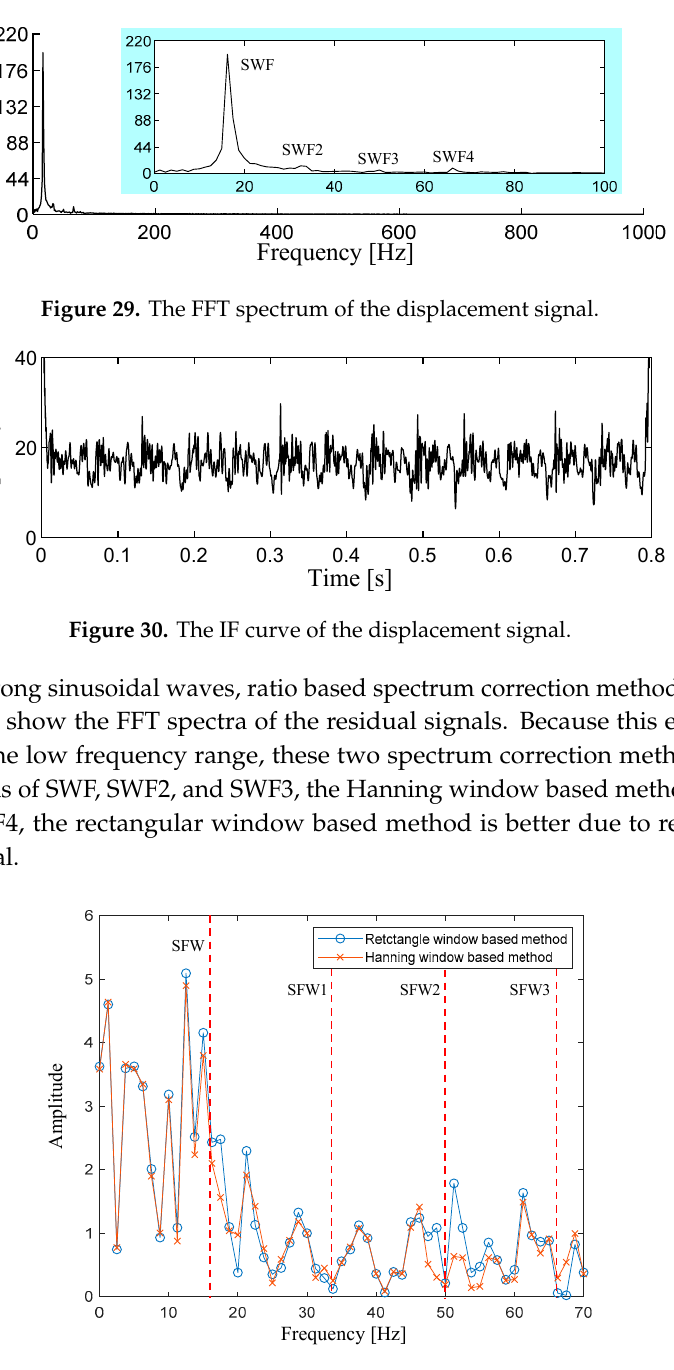
Figure 31. FFT spectra of the residual signals after sinusoidal wave reductions.